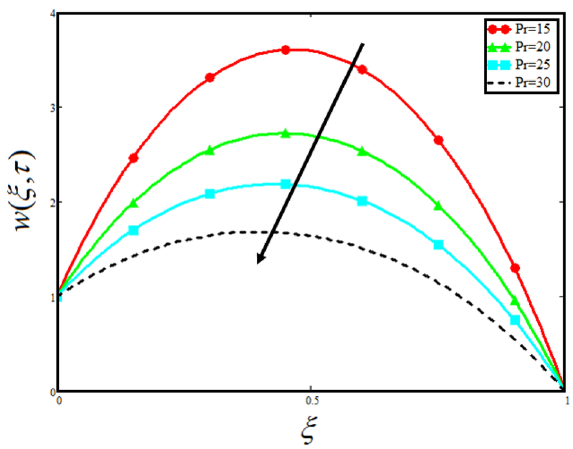
Figure 11. Variation in velocity of nanofluid against different values of Pr when τ = 1 , φ hnf = 0.02 , α = 0.5 , Gr = 4 , G = 2 , (cid:31) = 3 , β = 1.2 and Re = 1.2 .